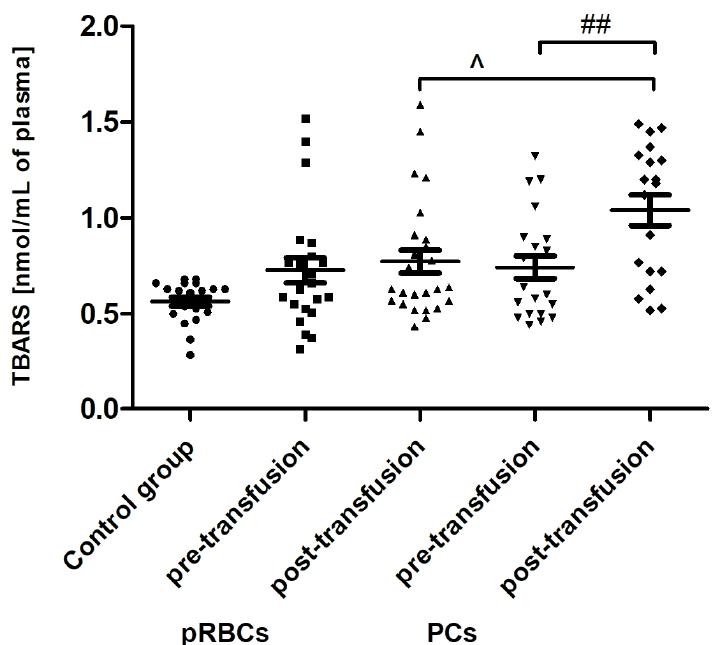
Figure 4. The concentration of thiobarbituric acid reactive substances (TBARS) in the plasma of healthy volunteers (control group) and AML patients before and after transfusion of the blood component. Scatter plots show all of the data values obtained. Data are presented as mean ± SE. ## p < 0.01 compared post- versus pre-transfusion; ^ p < 0.05 compared post-transfusion pRBCs versus PCs; statistically significant according to the Tukey test. pRBCs—packed red blood cells; PCs—platelet concentrates.